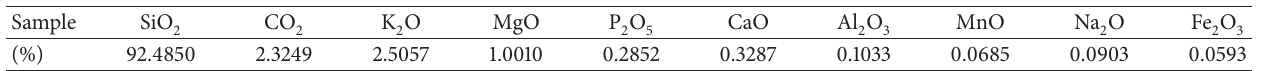
Table 1: The contents of silica